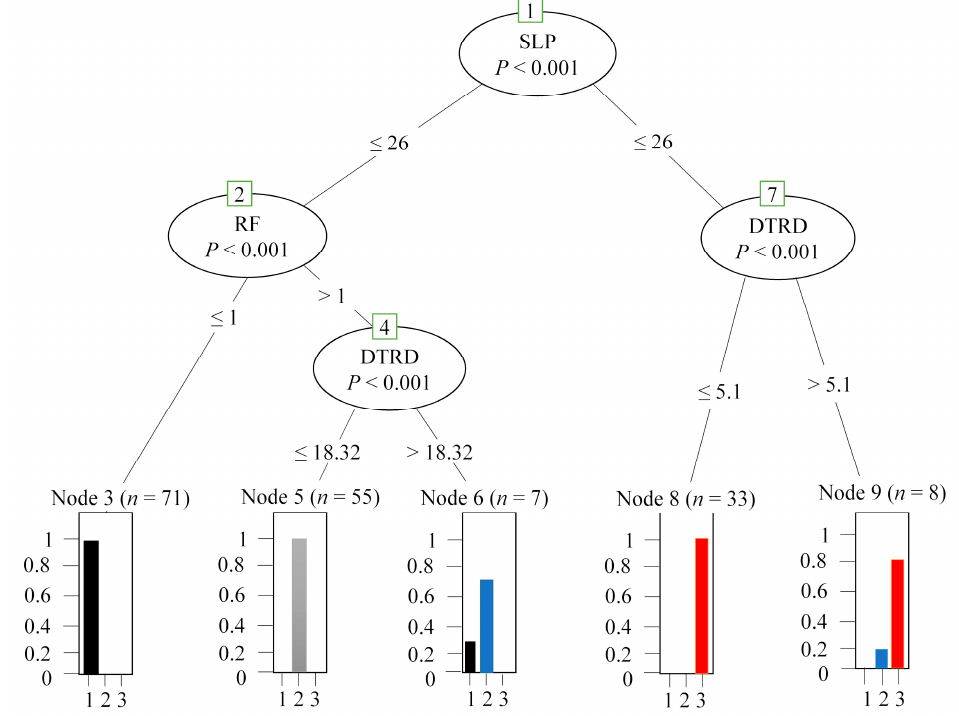
Figure 6. Classification and interpretation of the chances of a landslide based on the training data using the decision tree algorithm.